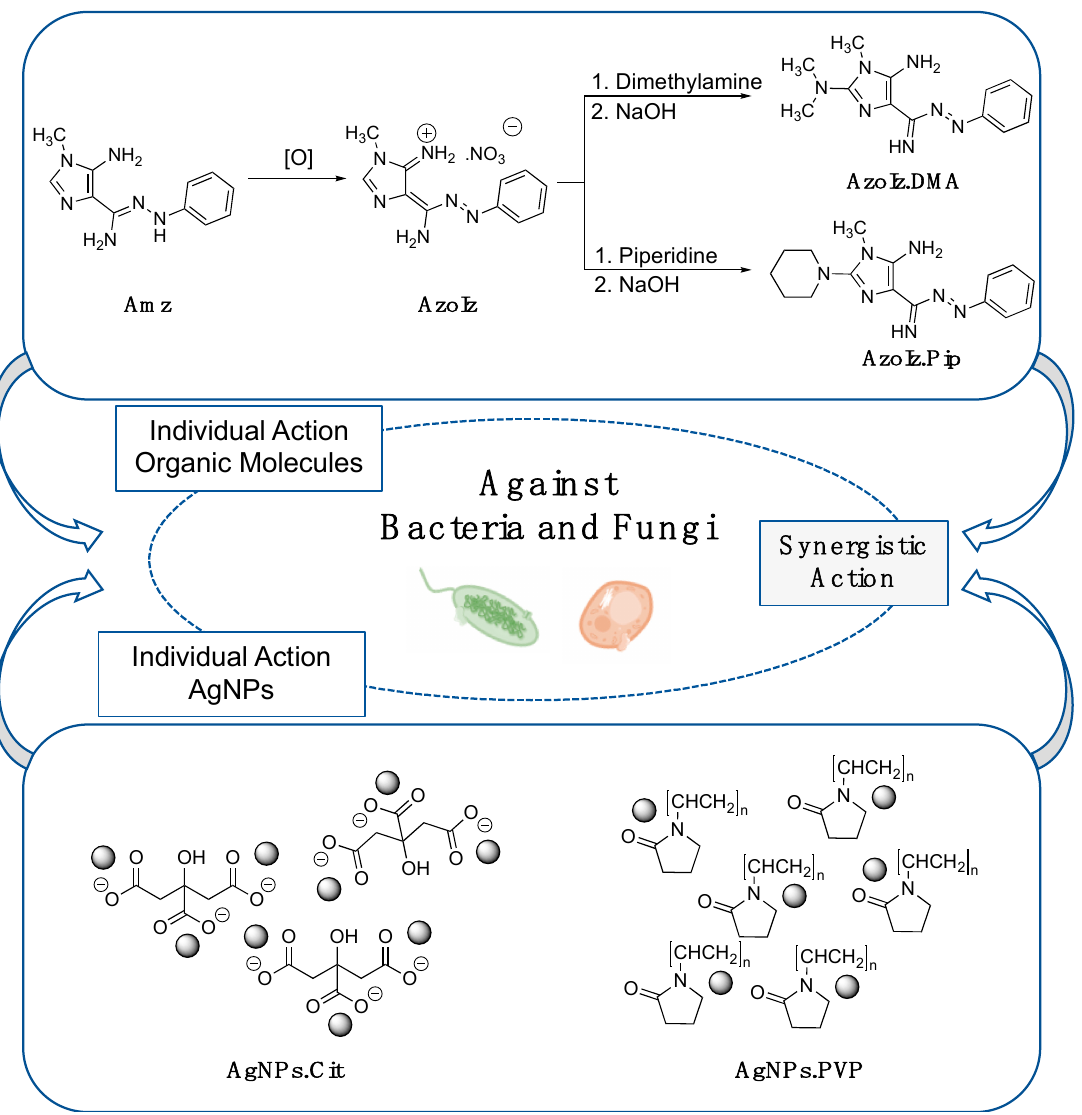
Figure 1. Schematic representation of the methodology adopted to obtain Amz/AzoIz and AgNPs conjugates.